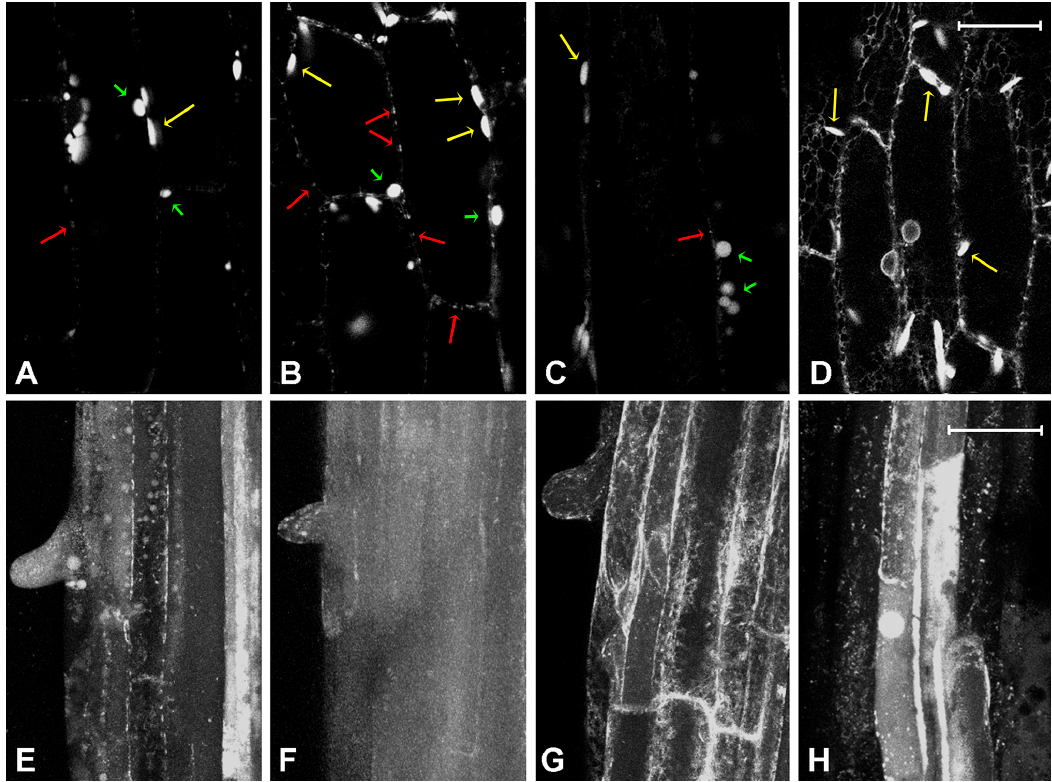
Figure 5. Fluorescent patterns of GFPChi vacuolar marker, in different tissues. Single confocal section of hypocotyl’s cells in ( A ) control; hypocotyl’s cells treated with ( B ) 5 mg/L (13 µM) kiteplatin, ( C ) 5 mg/L (13 µM) oxaliplatin, or ( D ) 5 mg/L (17 µM) cisplatin. Long yellow arrows indicate ER bodies while short green arrows indicate different large round-shaped compartments and long red arrows indicate pre-vacuolar-compartments (PVCs). Four confocal sections projection of young root at the end of elongation stage (emerging trichoblasts) in ( E ) control or ( F ) treated with 10 mg/L (26 µM) kiteplatin, ( G ) 10 mg/L (25 µM) oxaliplatin, or (H) 10 mg/L (33 µM) cisplatin. Scale bar: 20 µm.